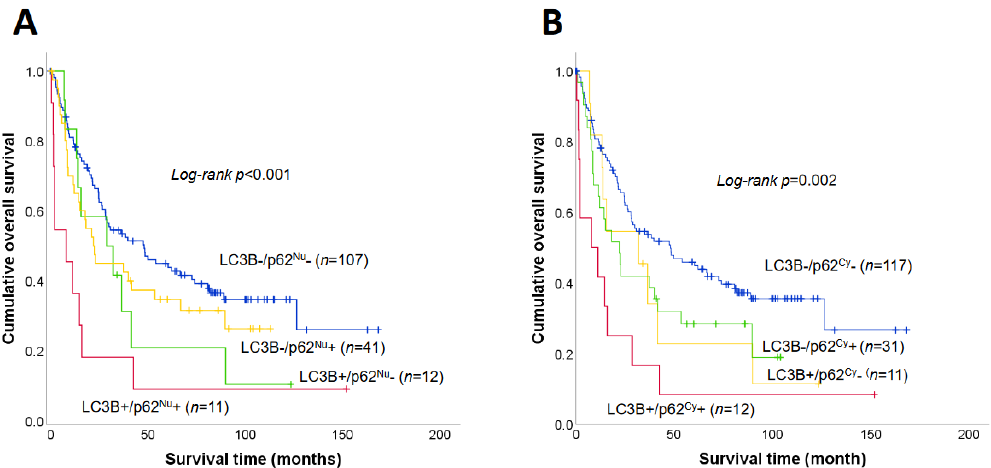
Figure 5. Survival analysis of SIAC patients based on the combination of LC3B and p63 expression. Survival differences were observed among four SIAC patient groups classified according to their LC3B and p62 Nu expression and LC3B and p62 Cy expression. The survival time of patients with LC3B+/p62 Nu + expression was significantly shorter (median 7.9 months) than those with LC3B − /p62 Nu − (median 48.1 months), LC3B − /p62 Nu + (median 22.0 months), and LC3B+/p62 Nu − (median 28.8 months) (log rank p < 0.001) ( A ). Patients with LC3B+/p62 Cy + expression had significantly shorter OS (median 7.9 months) than those with LC3B − /p62 Cy − (median 48.1 months), LC3B − /p62 Cy + (median 22.0 months), and